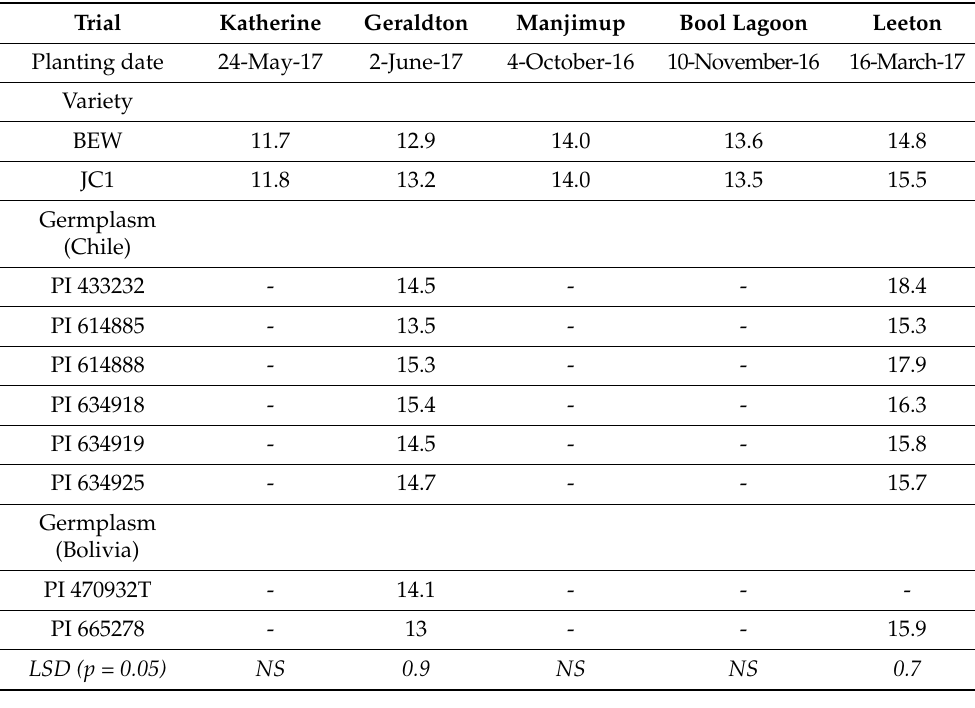
Table 15. Seed protein % at selected field